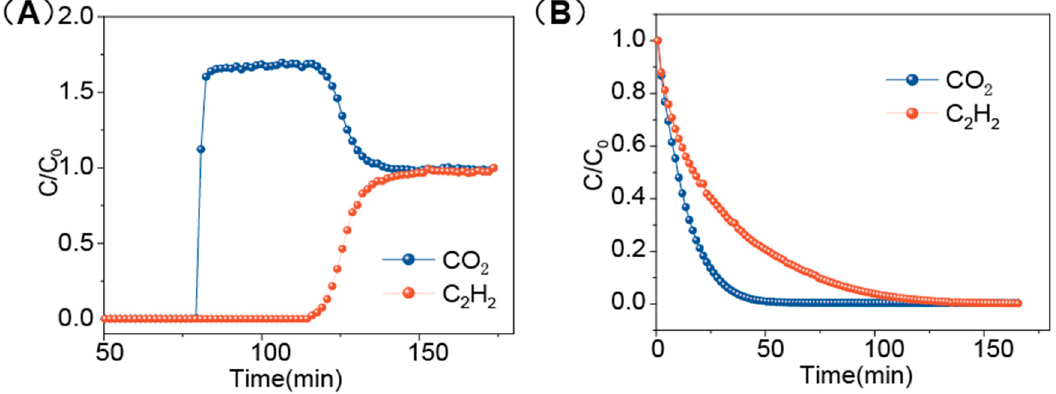
Figure 5. ( A ) Column breakthrough experiments of C 2 H 2 /CO 2 separation in 1 with a total flowrate of 2 mL/min at 25 °C. ( B ) Regeneration of 1 using an Ar purge of at 100 °C with a flow rate of 3 mL/min.